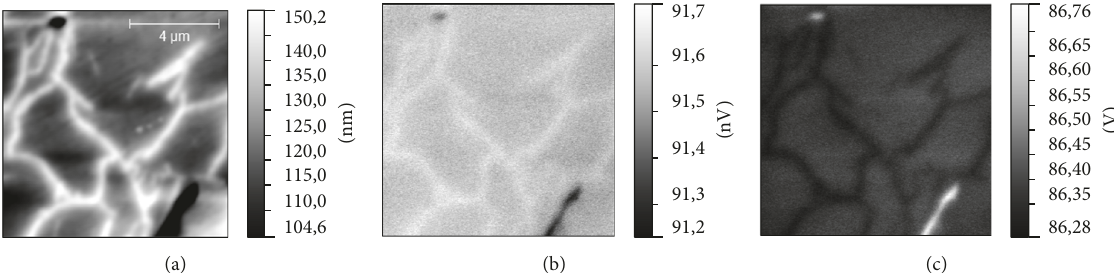
Figure 8: The results of EFM measurements of S2 sample: (a) topography of the sample, (b) EFM amplitude, and (c) EFM phase.